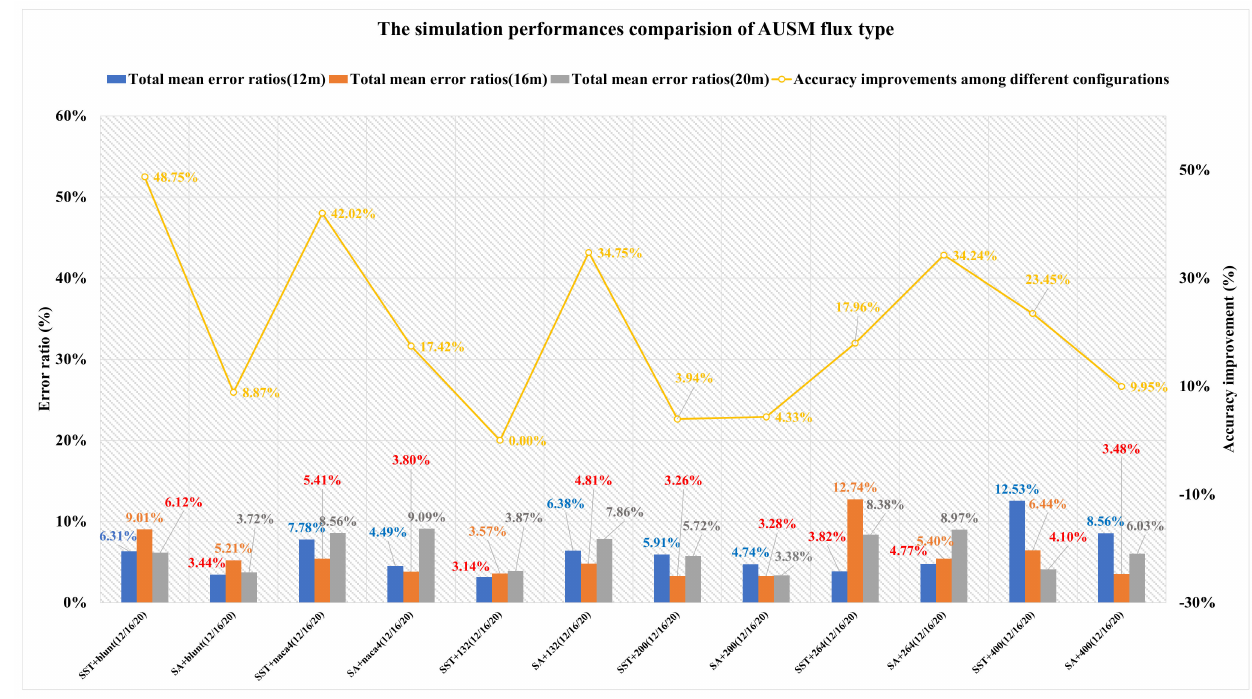
Figure 36. Comparison of the simulation performances of AUSM flux type under different simula-tion